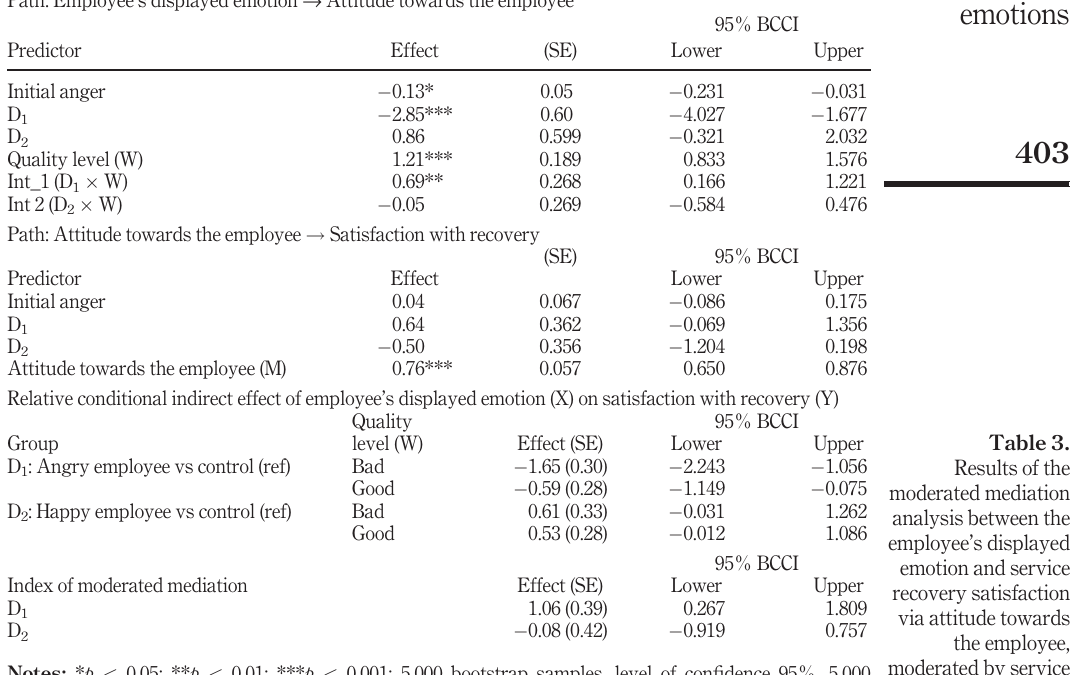
Table 3. Results of